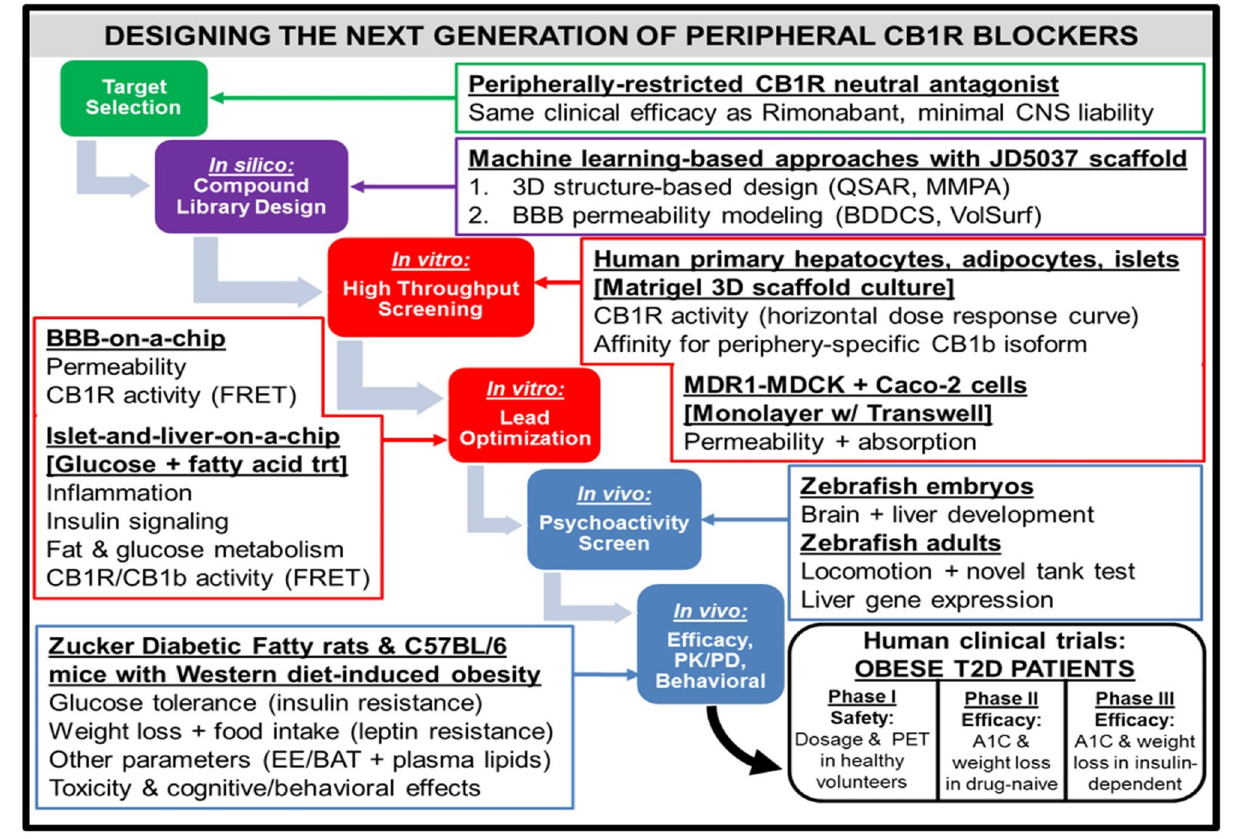
(BDDCS) ( 159) in order to filter out compounds with undesirable BBB penetrability. Two successive in vitro screening procedures will be utilized on the remaining lead compounds. The first will consist of a high-throughput screen, using primary cells from relevant peripheral tissues to characterize efficacy and Transwell